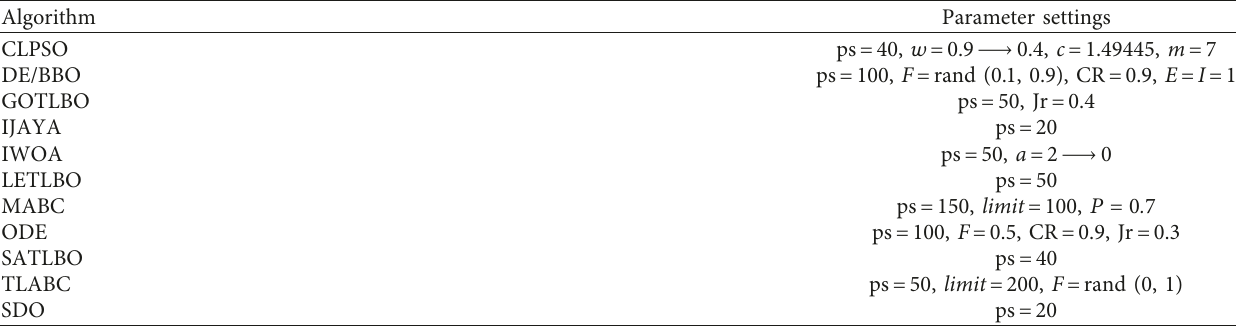
Table 2: Parameter settings for involved algorithms.